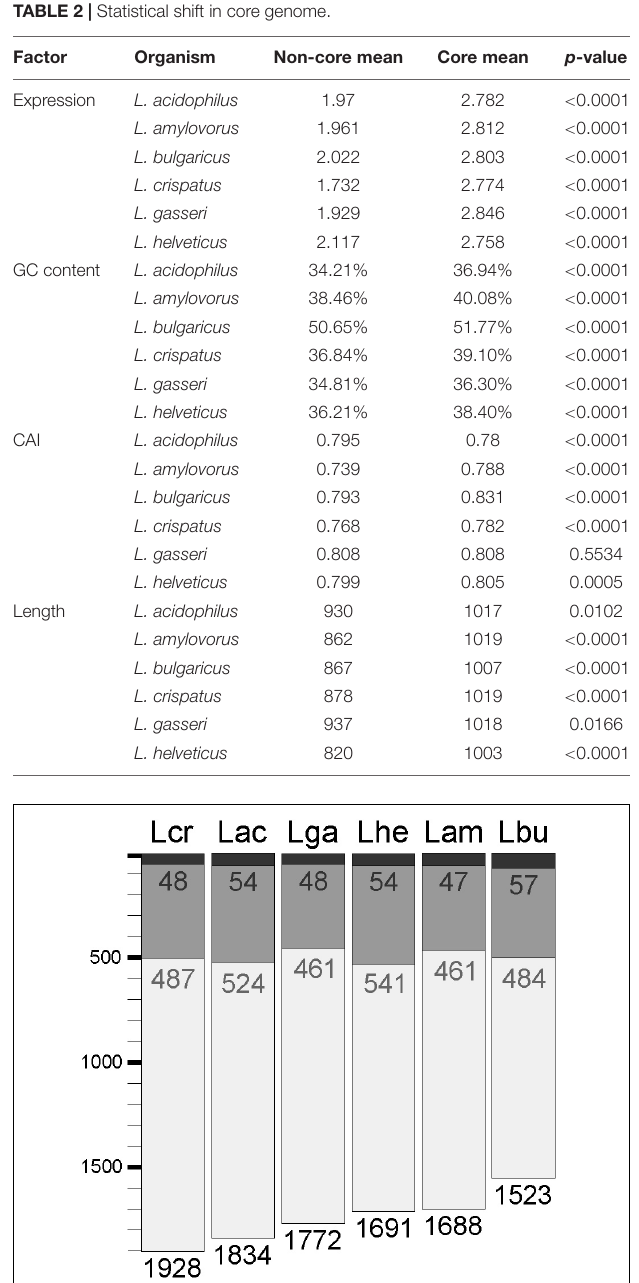
FIGURE 6 | Core transcriptome of L. acidophilus complex. The waterfall plot of each individual organism demonstrates the total number of coding sequences in each genome (light gray bar), the number of genes that constitute 90% of the mRNAs in the cell (dark gray bar), and the number of genes that constitute 50% of the mRNAs in the cell (black